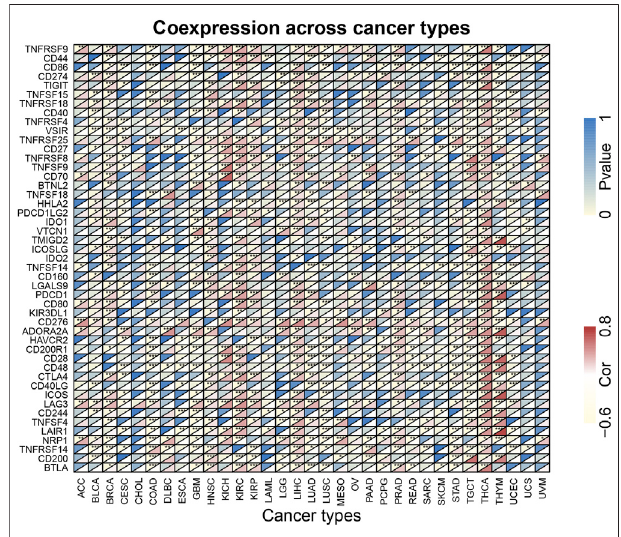
FIGURE 7 | The correlations between KIF18B expression and immune- relatedfactorsinvariouscancers.*indicates p < 0.05,**indicates p < 0.01,*** indicates p <